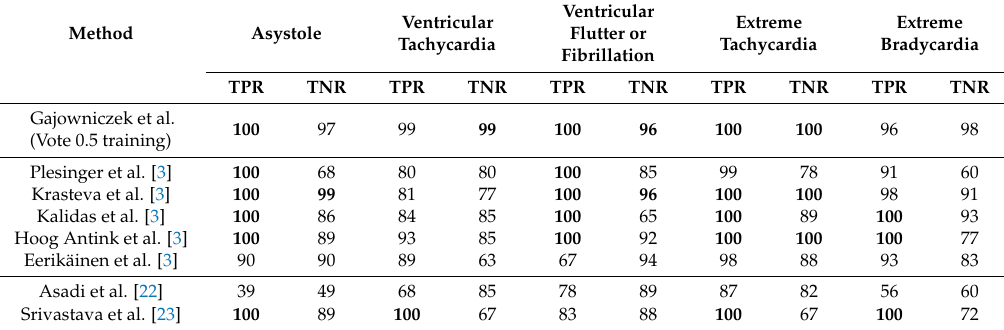
Table A6. Comparison of our best solution (Vote 0.5 training), top 5 solutions from the 2015 PhysioNet/Computing in Cardiology Challenge (after the follow-up phase), and two other solutions that used RF in their approach. All the results were calculated for the training